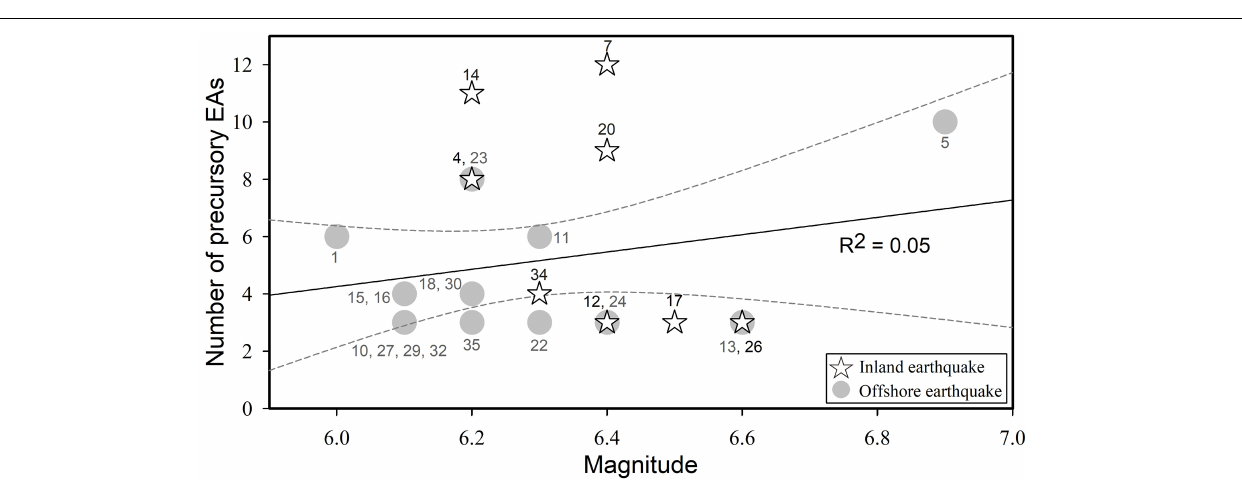
FIGURE 5 | Variation diagrams showing the relationship between earthquake magnitude and distribution of the number of total precursory E Index anomalies. Solid and open symbols denote the inland and offshore earthquakes with the associated anomalous OLR E Index . Dashed lines indicate the 95% confidence interval of the data